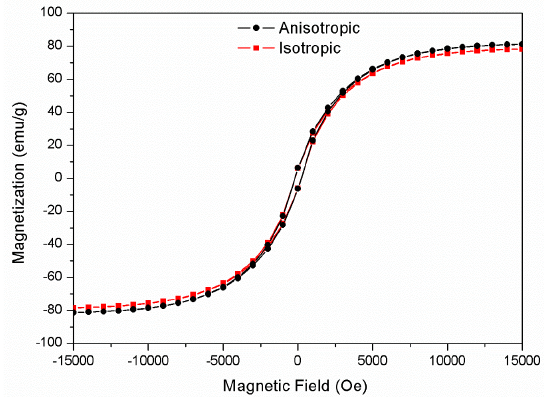
Figure 3. Magnetic hysteresis loop of the Co-MRE. Table 3. Magnetic properties of isotropic and anisotropic MRE.